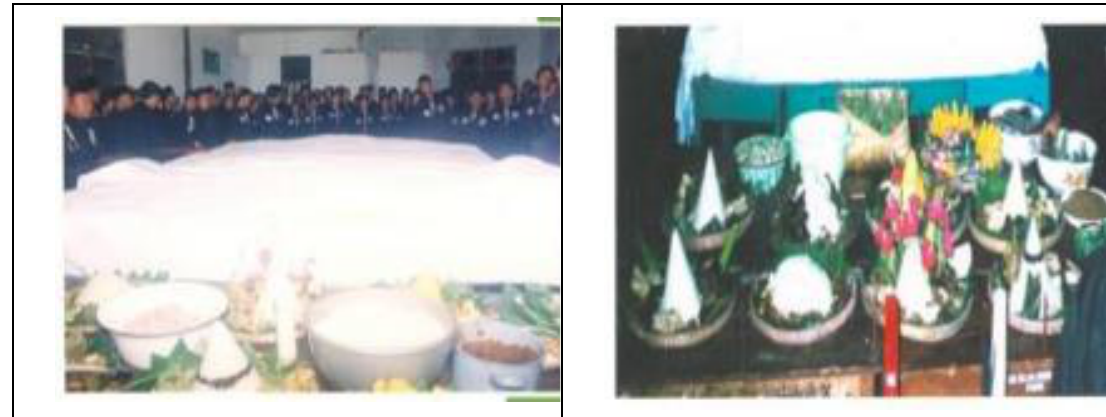
Fig. 2 Mori and Buceng Uborampe as a ritual procession for the ratification of